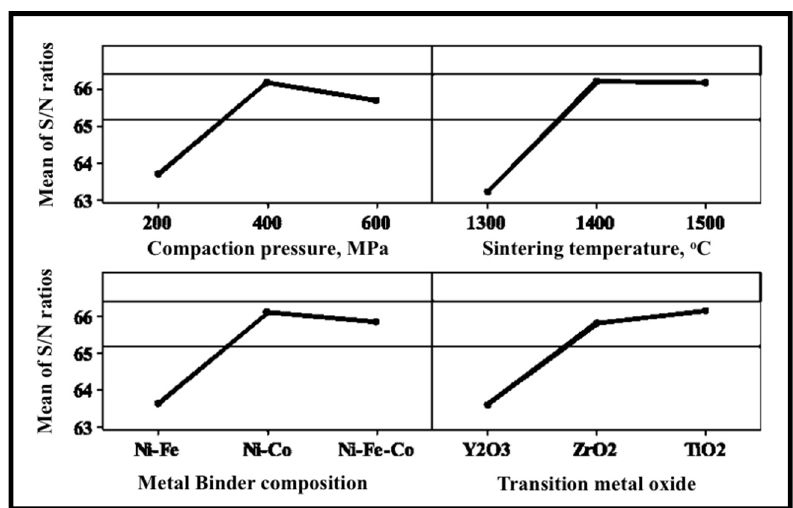
Figure 9. Mean of S/N ratios for compressive strength of samples versus levels of input parameters. Figure 9. Mean of S / N ratios for compressive strength of samples versus levels of input